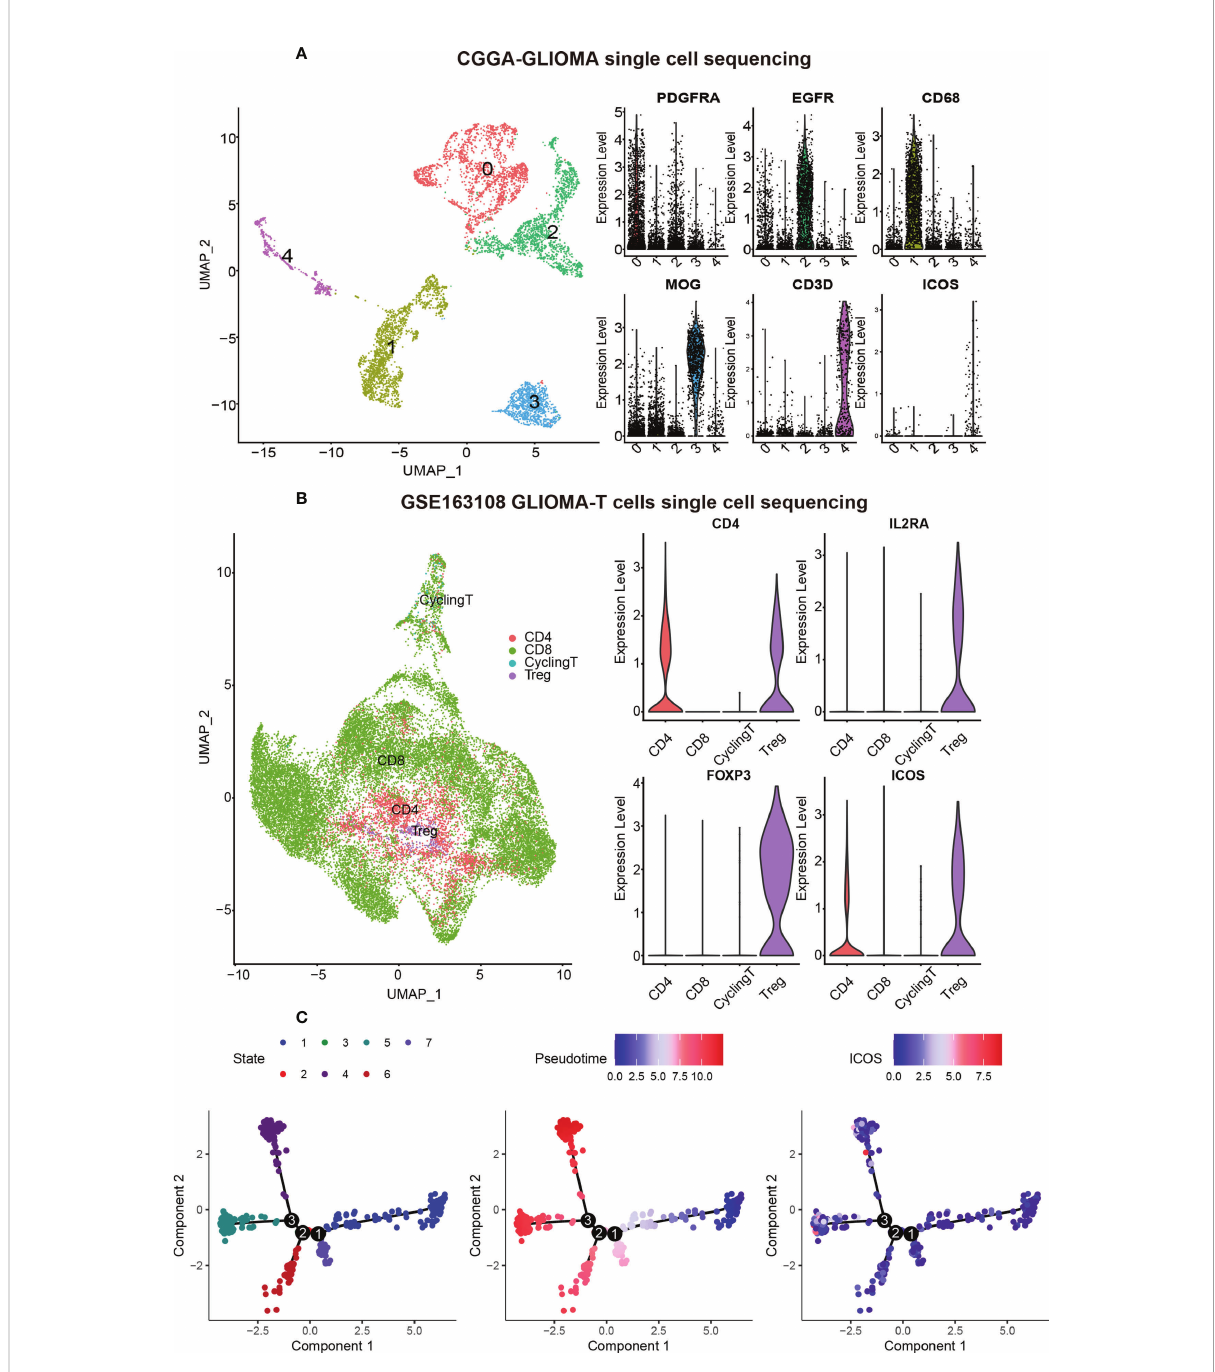
FIGURE 10 ICOS expression on different cell types based on single-cell RNAseq from CGGA and GSE163108 datasets. (A) Five cell clusters were identi fi ed in the CGGA sc-sequencing dataset. Clusters 0 and 2, highly expressing PDGFR and EGFR, could be annotated as glioma cells. Cluster 1, highly expressing CD68, was annotated as macrophages. Cluster 3, highly expressing MOG, could be identi fi ed as normal neurons. Cluster 4 highly expressing CD3D was annotated as T cells, and ICOS was mainly expressed in T cells rather than other cells. (B) Four types of glioma-in fi ltrated T cells were annotated by the data provider of GSE163108. We veri fi ed Treg ’ s cell markers (CD4, IL2RA [also termed CD25], and FOXP3), and ICOS was found to be particularly expressed in Tregs. (C) Single-cell trajectory analysis of Tregs reveals seven states. Cells are colored based on states (left), pseudotime (middle), and ICOS expression (right). State 1 could be identi fi ed as the early-stage Tregs, while states 4, 5, and 6 could be de fi ned as the mature Tregs. ICOS is more upregulated in mature